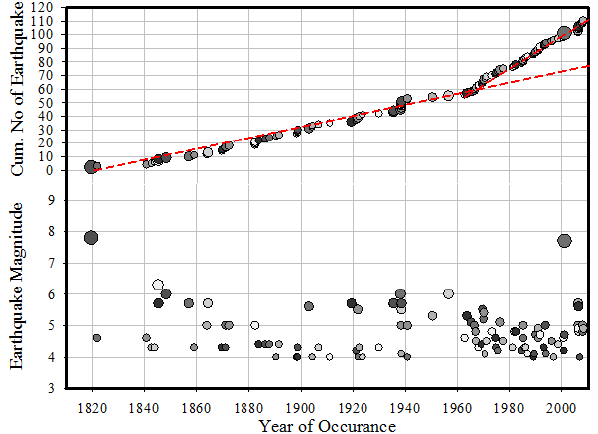
Fig. 4. Catalogue completeness by Cumulative Visual (CUVI) method for Gujarat by using the earthquake catalogue ( M w ≥ 4) available on ISR-Gujarat web site (www.isr.gujarat.gov.in)